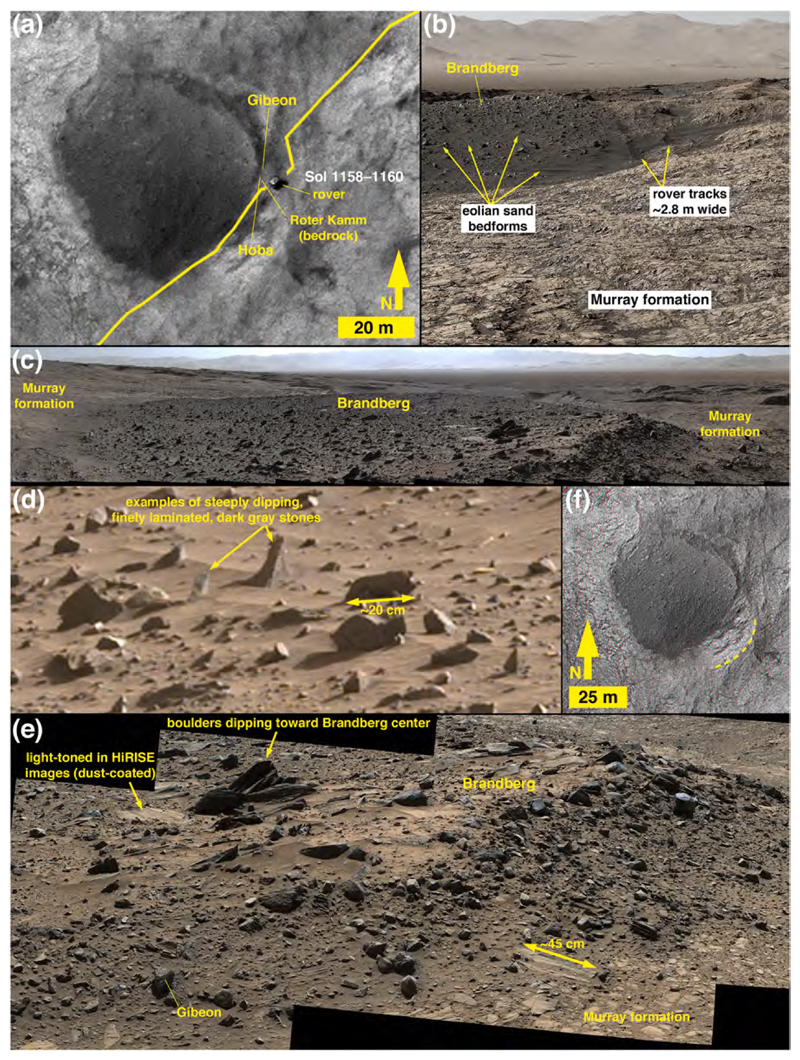
(a) Brandberg and the Curiosity rover as viewed by HiRISE on Sol 1159. Yellow trace indicates the rover traverse; drive direction was from northeast to southwest. ChemCam targets are indicated by name. (b) Eastern Brandberg. In this scene, Brandberg is downhill from the rover; the near side of Brandberg forms a shallow depression. Rover tracks provide scale. Eolian bedforms explain the faint lineated texture observable in HiRISE images. (c) Brandberg as viewed from the northeast. (d) Examples of steeply dipping cobble-sized angular clasts in Brandberg. (e) Examples of clast variety in northeastern Brandberg. The largest boulder-sized clasts dip toward the center of the circular landform. Boulders with relatively flat, skyward-facing surfaces are coated with dust and thus appear light-toned when seen from above in HiRISE images. The ChemCam target, Gibeon, is indicated. (f) Red/cyan stereo pair anaglyph produced from two HiRISE images; the dashed yellow arc indicates a ridge that might be an indicator that Brandberg occurs within the eroded remains of an impact structure. (For interpretation of the references to color in this figure, the reader is referred to the web version of this article.)